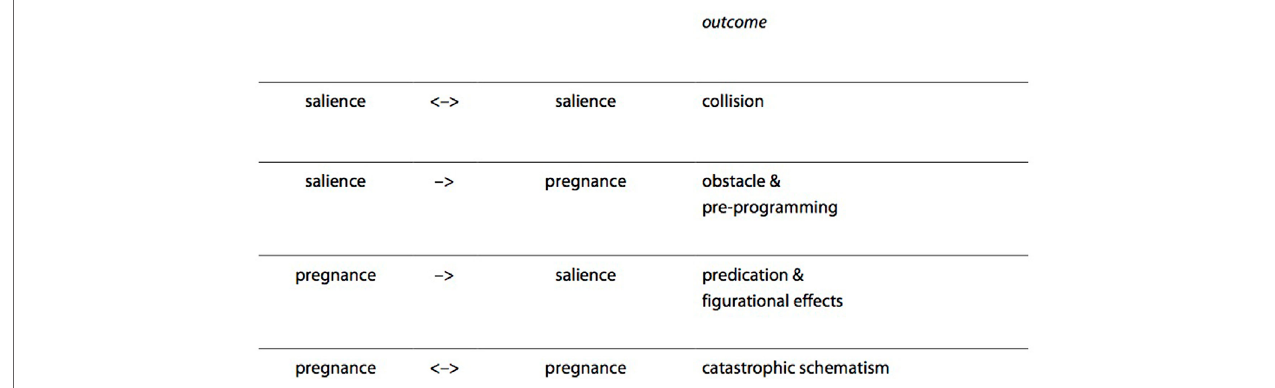
FigUre 1 | Thom’s theory of the interactions between saliences and pregnances via emission, capture, impregnation, and